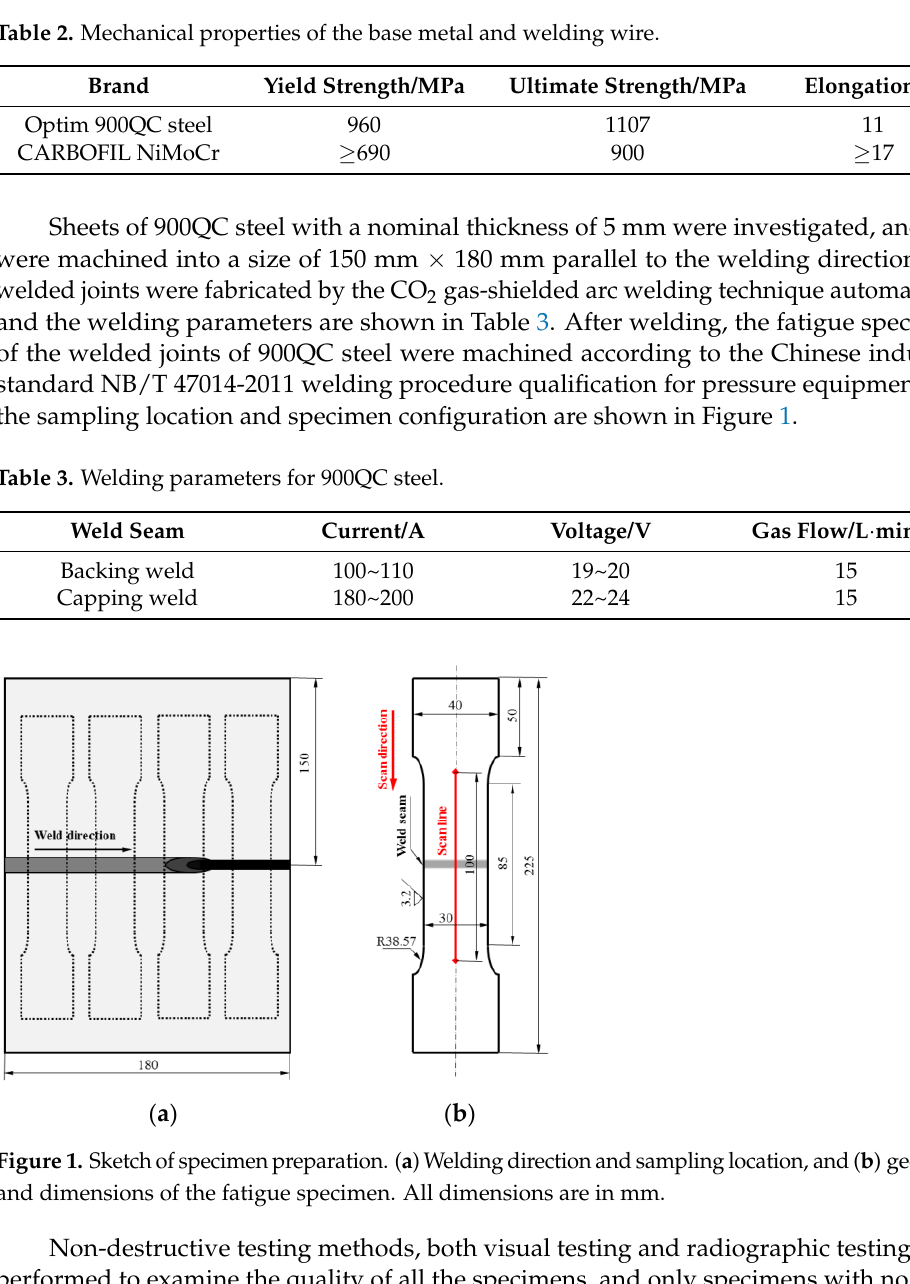
Table 1. Chemical compositions of the base metal and welding wire (in wt.%).